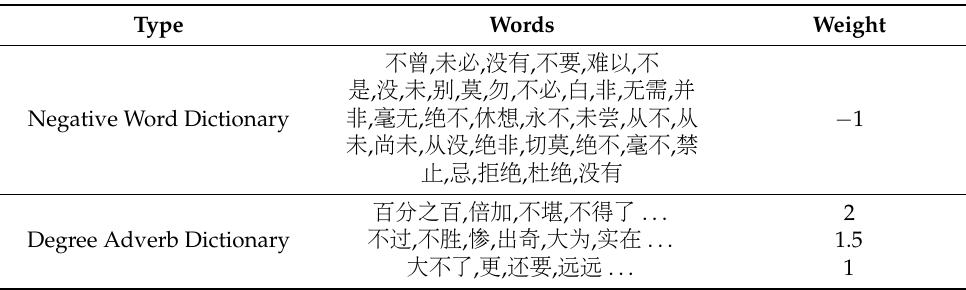
Table 4. Negative word and degree adverb